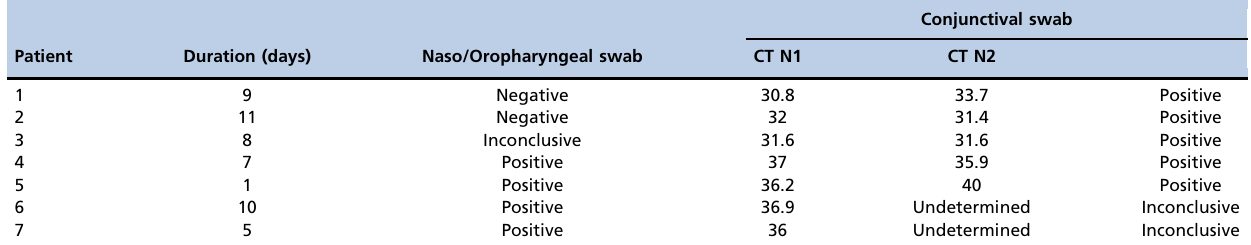
Table 2 - Comparison of rRT-PCR results for SARS-CoV-2 in naso/oropharyngeal swabs and conjunctival swabs from COVID-19 patients with viral detection in ocular